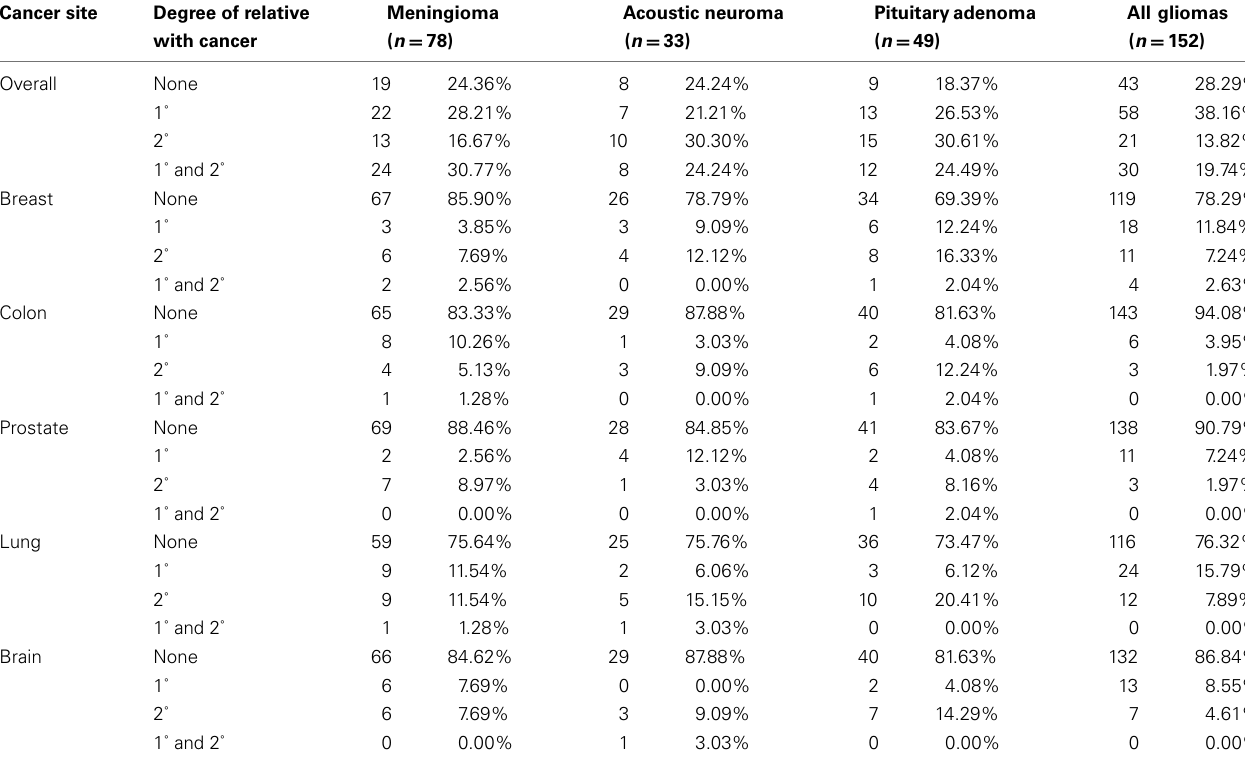
Table 2 | Overall and site-specific family history of cancer by brain tumor histologic